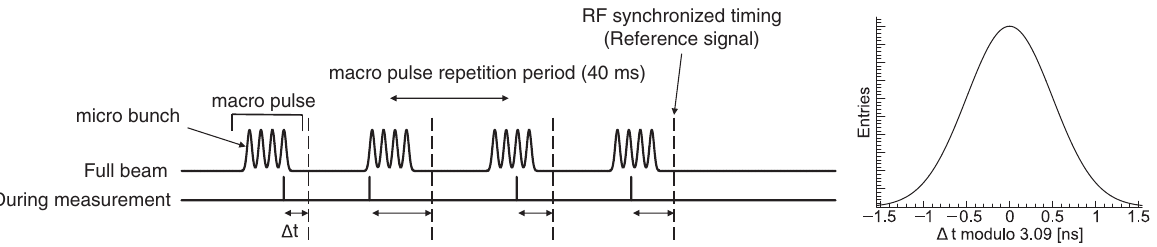
FIG. 1. Schematic of the muon beam structure. The intensity limits the measurement to the order of one muon per macro pulse to measure the bunch width using this method. The monitor measures the time difference between the one muon included in a pulse and reference timing, Δ t . An example of the microbunch structure (left) and Δ t distribution modulo rf period of 3.09 ns